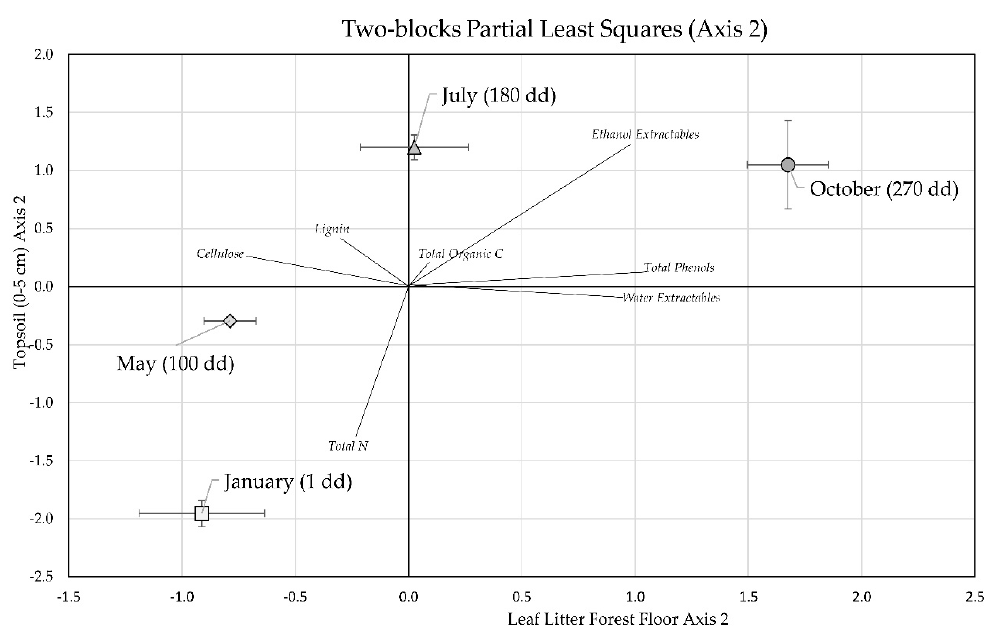
Figure 5. Graphical representation of Axis 2 of the two-block PLS. Variation on the x -axis is forest floor leaf litter and on the y- axis the topsoil. Values represent the mean score for the replicates ( N = 6) with standard error of the mean. Months and decomposition days in the litterbag experiment (dd) are reported.